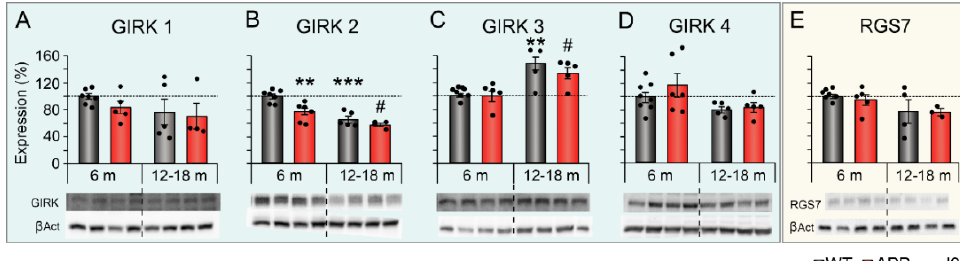
Figure 3. Effect of genotype and age on hippocampal levels of GIRK channel subunits and modulator. Protein levels of GIRK channel subunits (1–4) and modulator (RGS7) in the hippocampus of non-transgenic (WT) and APP Sw,Ind J9 mice at 6 and 12–18 months of age. ( A ) GIRK1, ( B ) GIRK2, ( C ) GIRK3, ( D ) GIRK4 and ( E ) RGS7. Data is expressed as percentage relative to 6-month-old WT mice (100%). ** p < 0.01, *** p < 0.001 vs. WT 6-month-old; # p < 0.05 vs. APP Sw,Ind J9 6-month-old. m, months; β Act, β actin.